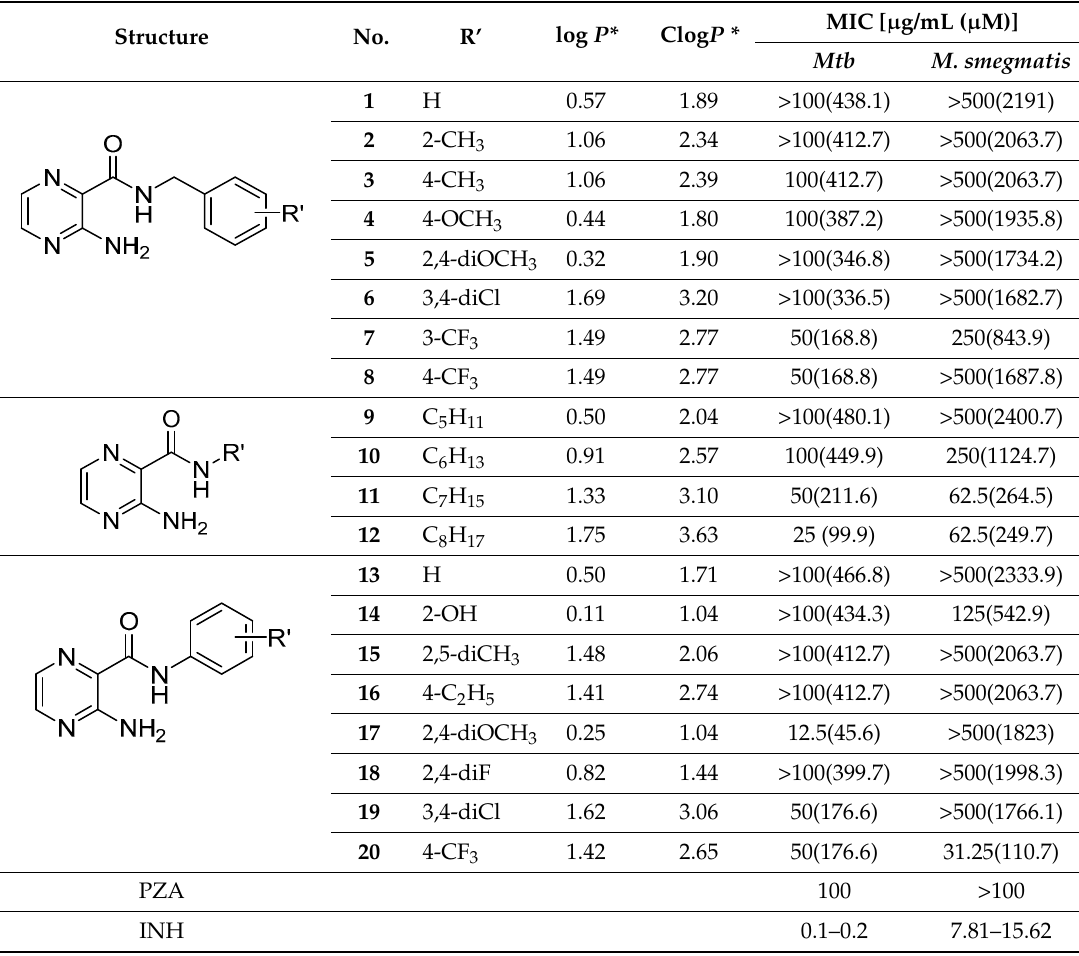
Table 2 . Prepared compounds, calculated partition coefficients log P and Clog P and antimycobacterial activity against Mtb and M. smegmatis .